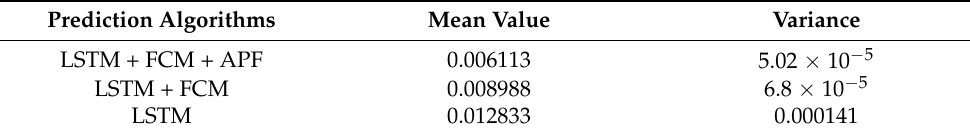
Table 5. The 5 − step of the longitudinal coordinate prediction results.